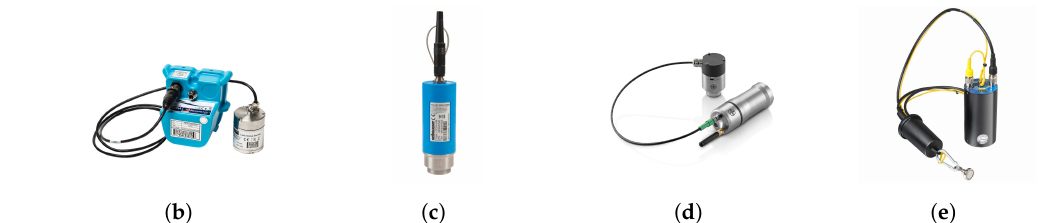
Figure 1. Range of vibro-acoustic loggers installed across metropolitan Sydney: ( a ) HWM PermaNET SU, ( b ) HWM PermaNET+, ( c ) SebaKMT Sebalog N-3, ( d ) Von Roll ORTOMAT-MTC, ( e ) Primayer Enigma3m. Table 1. Vibro-Acoustic Logger Deployment Details.